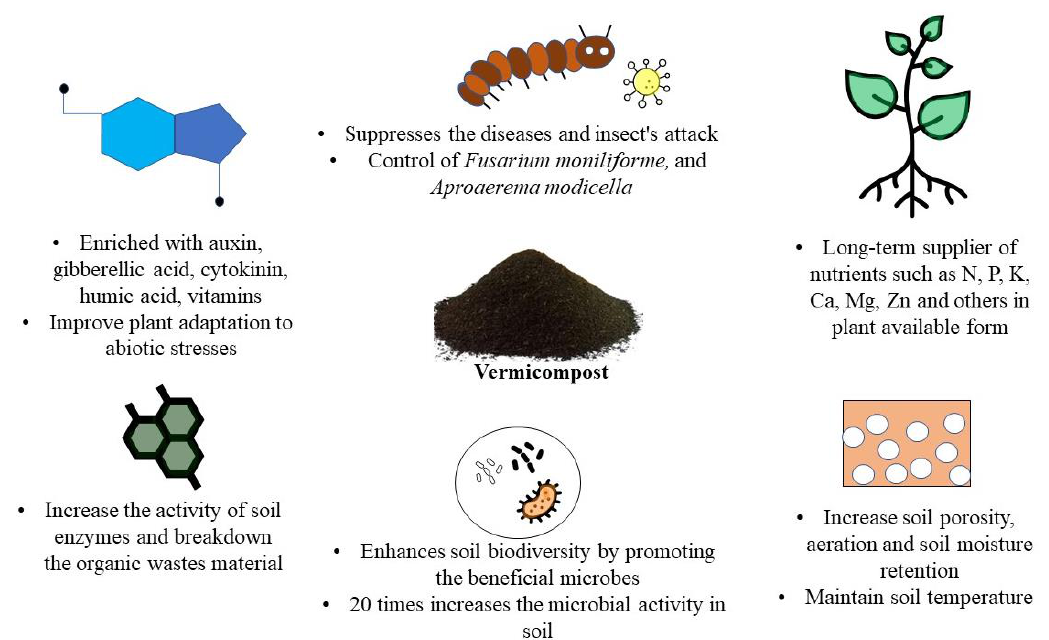
Figure 1. Vermicompost serves as a plant growth regulator and biocontrol agent, enhancing the physical, biochemical, and fertility properties of soil while suppressing pest attacks.